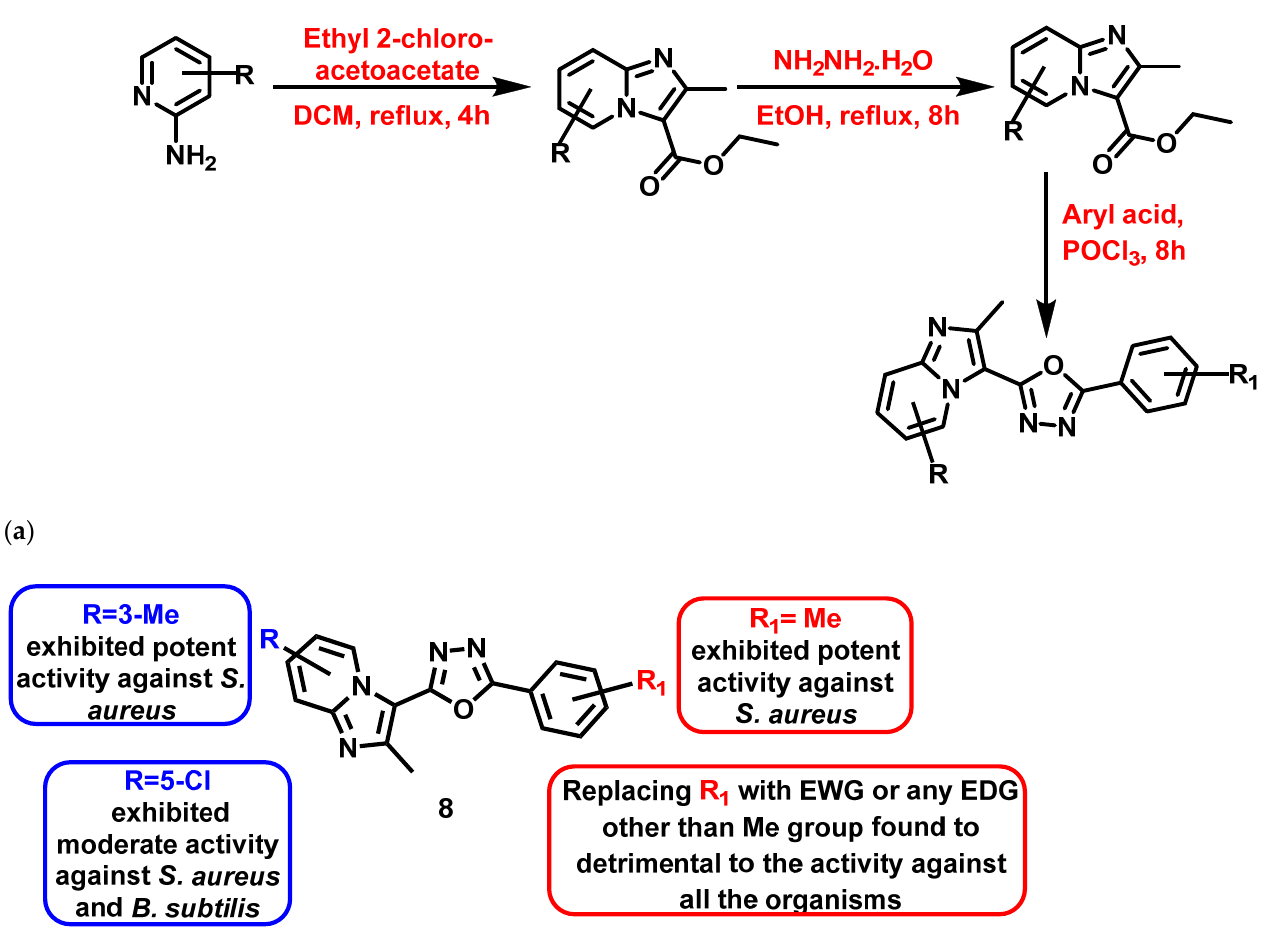
Figure 9. ( a ) Synthetic scheme of newly IZP derivatives flanged with oxadiazole nucleus. Signatures of compounds according to Kuthyala et al., 2018 [63]. ( b ) A brief SAR of trisubstituted imidazopyridine-oxadiazole hybrids. Signatures of compounds according to Kuthyala et al., 2018 [63]. Devi et al., 2017 [64], synthesized pyrazolopyridinone-fused IZPs using one-pot tandem reactions through an In(OTf)-assisted Groebke-Blackburn Bienayme multi-component E. coli , P. aeruginosa , S. aureus , and Staphylococcus epidermis ( S. epidermis ) when